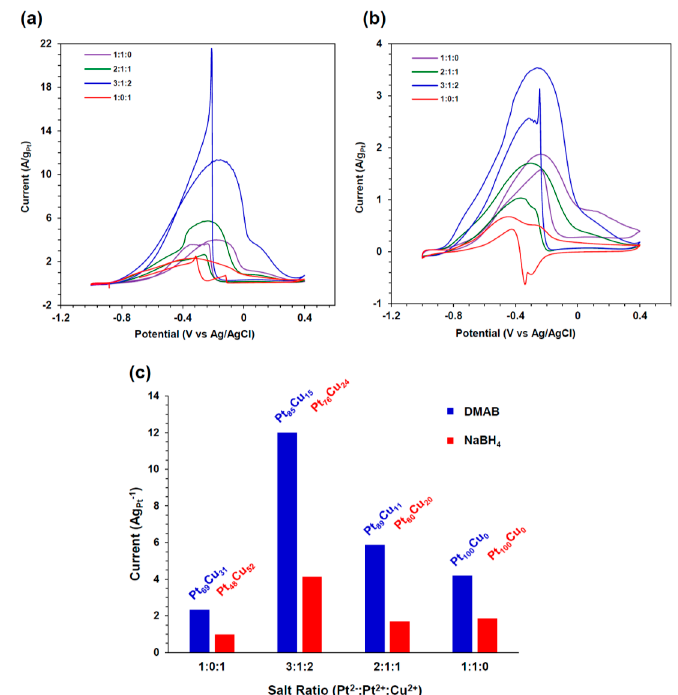
Figure 8. Ethanol oxidation peak currents (Ag Pt − 1 ) in 1 M KOH and 1 M ethanol at 0.5 mV/s for Pt 2 − :Pt 2 + :Cu 2 + salt ratios of 1:1:0, 2:1:1, 3:1:2, and 1:0:1 reduced in ( a ) DMAB and ( b ) NABH 4 . ( c ) Volcano plot from data in ( a ) and ( b ) with Pt x Cu y mass ratios; DMAB (blue) and NABH 4 (red).